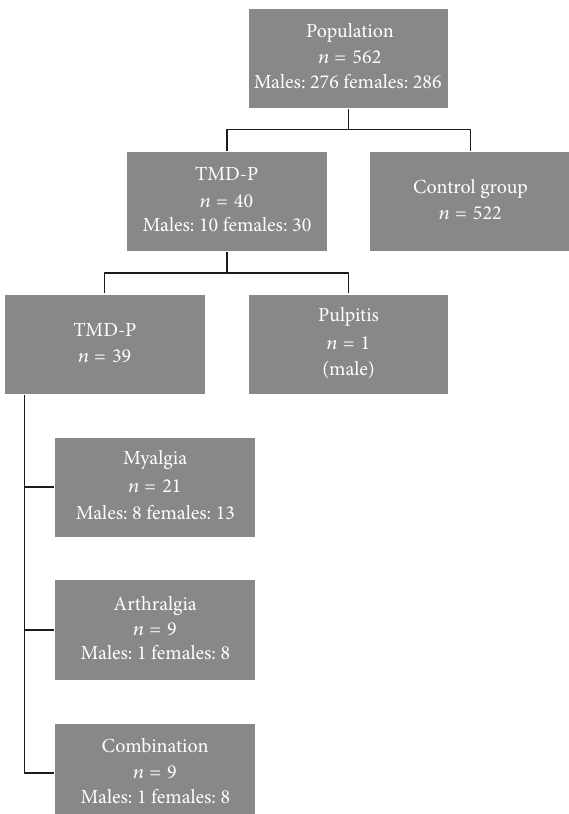
Figure 2: Flowchart showing the number of patients answering the TMD-P questions. The left column shows the case group with the distribution by sex. The right column shows the size of the control